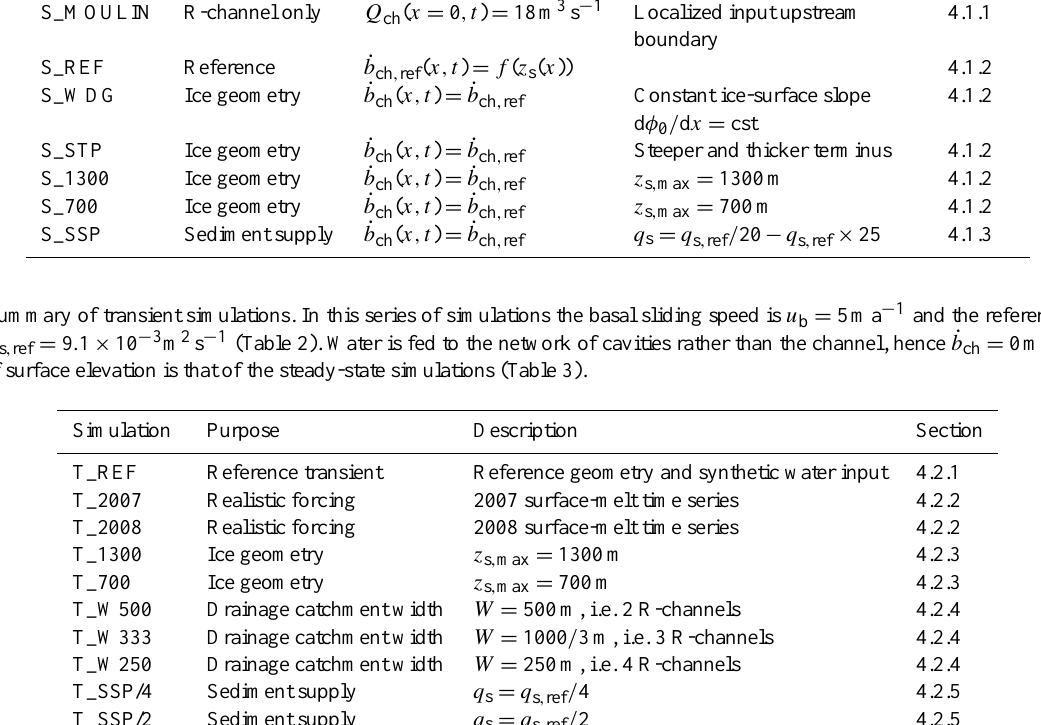
Table 3. Summary of steady-state simulations. For simulations in which meltwater input is a function of ice-surface elevation z s , we the channelized drainage system, and z s , min and z s , max are respectively the minimum and maximum ice-surface elevations. Note that − 7 ms − 1 corresponds to 7.6cm of ice melt per day assuming ρ ˙ b ssmax = 8 . 5 × 10